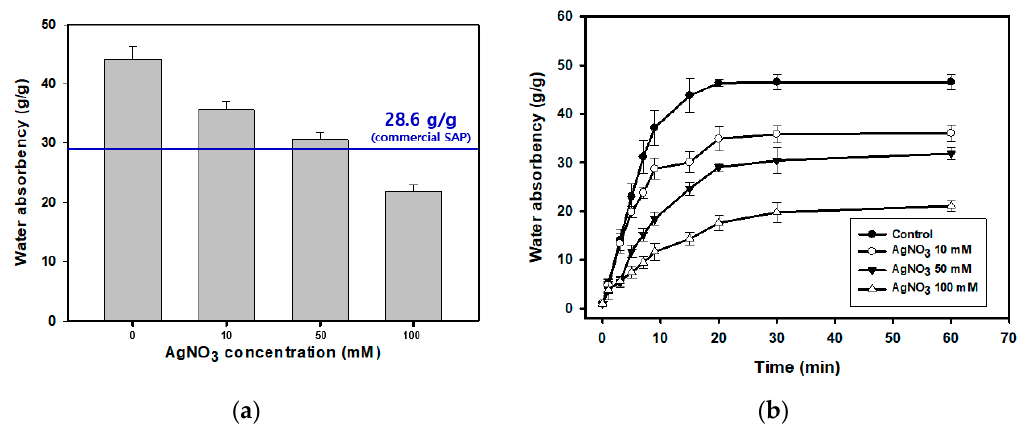
Figure 2. Water absorbency behavior of AgNP-SAP. ( a ) Water absorbency at equilibrium. ( b ) Swelling rate of AgNP-SAP prepared from different concentration of AgNO 3 (0.9 wt% NaCl solution was used).